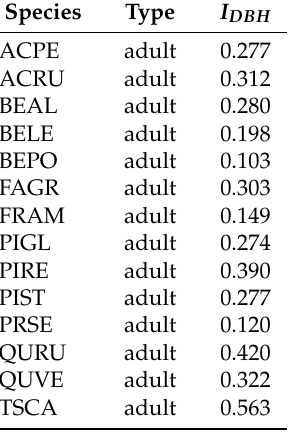
Table A4. Species DBH increment